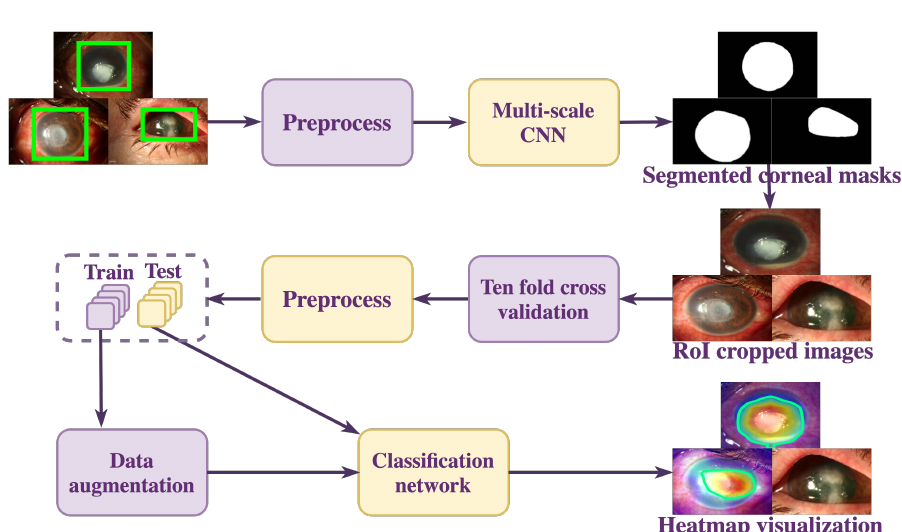
Figure 1. Proposed methodology for FK